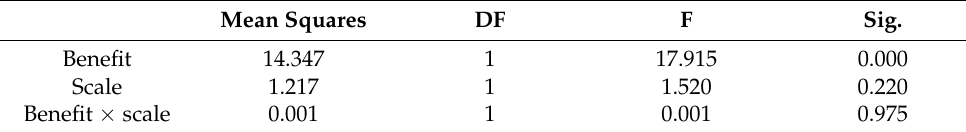
Table 6. Two-way ANOVA statistics of behavior intention regarding